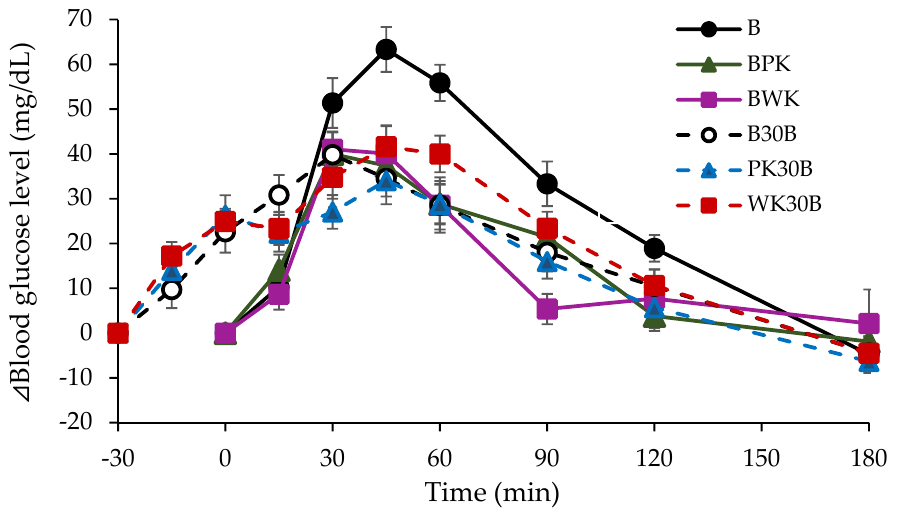
Figure 1. Mean difference between groups in ∆ Blood Glucose. Data are shown as mean ± SEM ( n = 12). No significant difference: Each treatment group. p < 0.05 vs. Bread, 30–180 min ( Dunnett’s test ).